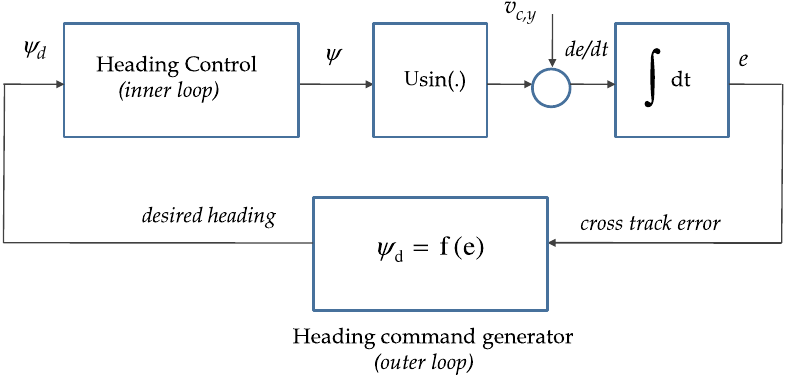
Figure 7. Path-following controller with two-scale inner-outer loop